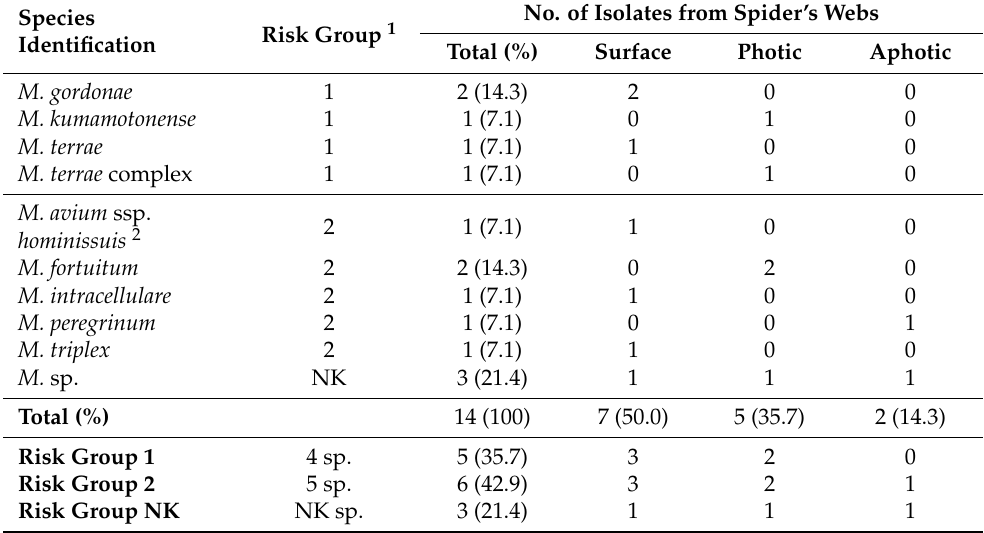
Table interpretation. M. = Mycobacterium ; ssp. = subspecies; sp. = species; NK = Not Known Mycobacterium sp.; 1 according to [31]; 2 identified according to Slana et al.